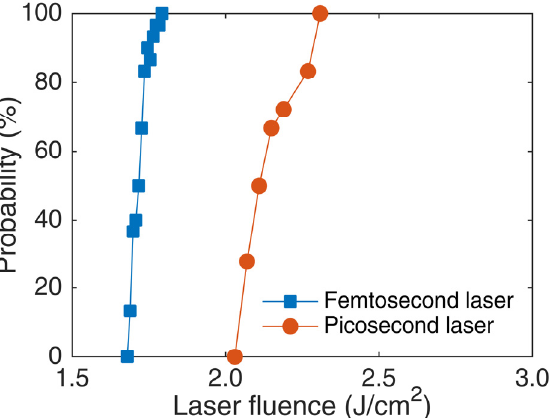
Figure 3. Damage probability distribution of multilayer film irradiated by femtosecond and picosecond lasers with different laser fluences.